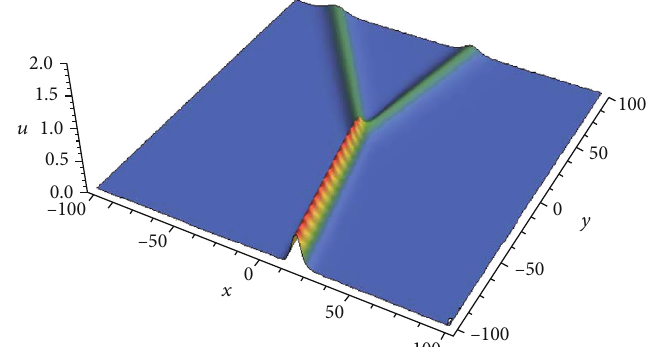
= 1/2 , k = 1 , p = 3/4 , p = 1 , 1 2 1 2